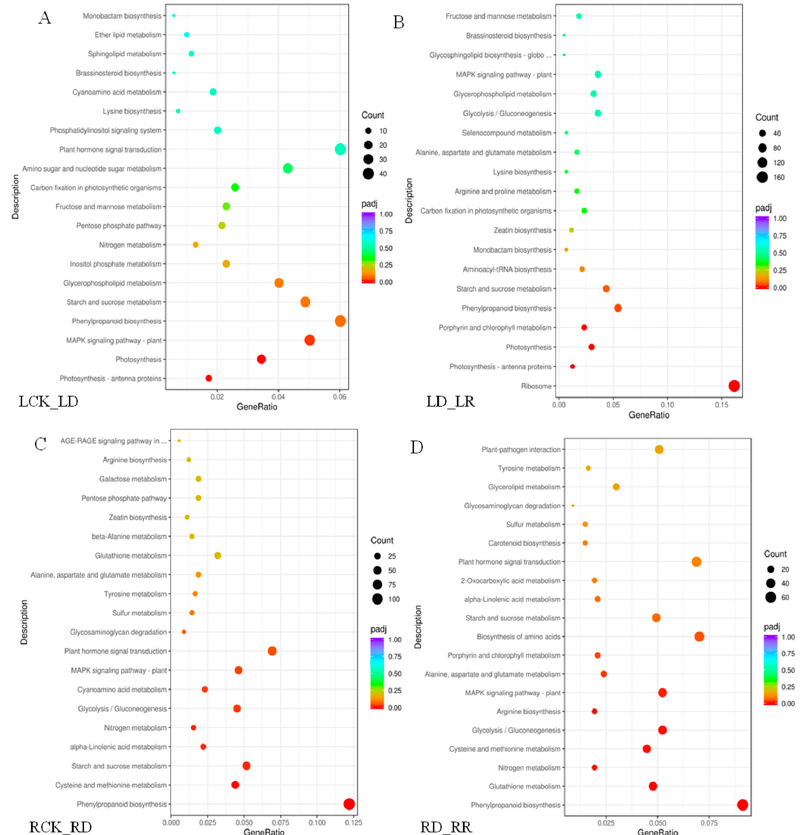
Figure 6. KEGG analysis of DEGs identified under drought and re-watering conditions. The “GeneRatio” shows the ratio of the number of DEGs to the total gene number in a specific pathway. Pathways are listed along the y -axis, while the x -axis indicates the enrichment factor. Red indicates a high q value while blue represents a low q value. The area of bubbles indicated the number of enriched DEGs. ( A ) KEGG analysis of DEGs identified between watered control (LCK) and drought (LD). ( B ) KEGG analysis of DEGs identified between drought (LD) and re-watering (LR). ( C ) KEGG analysis of DEGs identified between watered control (RCK) and drought (RD). ( D ) KEGG analysis of DEGs identified between drought (RD) and re-watering